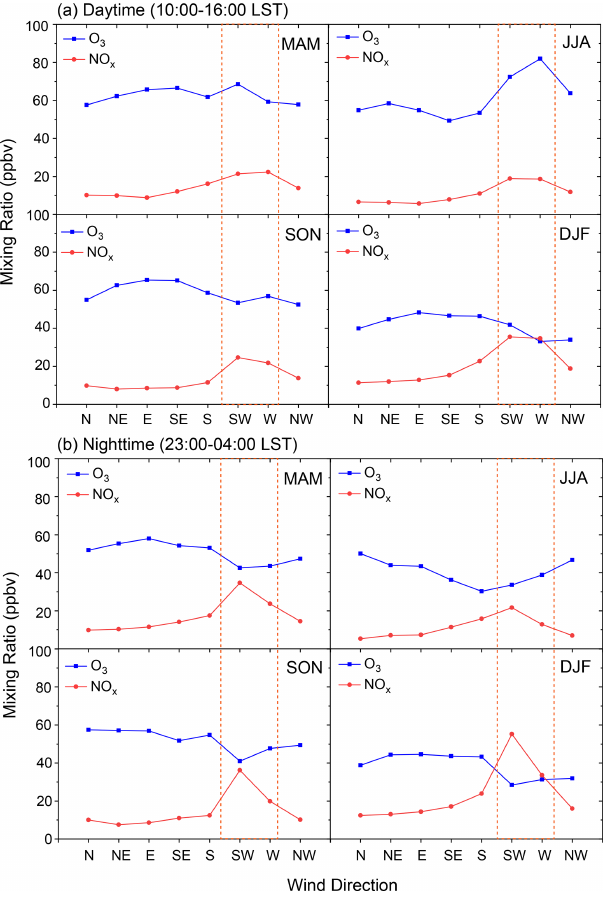
Figure 7. Daytime and nighttime mean O 3 mixing ratios (ppbv) at Sheshan Island (SSI) and NO x mixing ratios (ppbv) at the Dongtan (DT) site, a remote rural site near SSI, under north (N), northeast (NE), east (E), southeast (SE), south (S), southwest (SW), west (W) and northwest (NW) wind conditions in MAM (March–May), JJA (June–August), SON (September–November) and DJF (December– February), respectively, from 2012 to